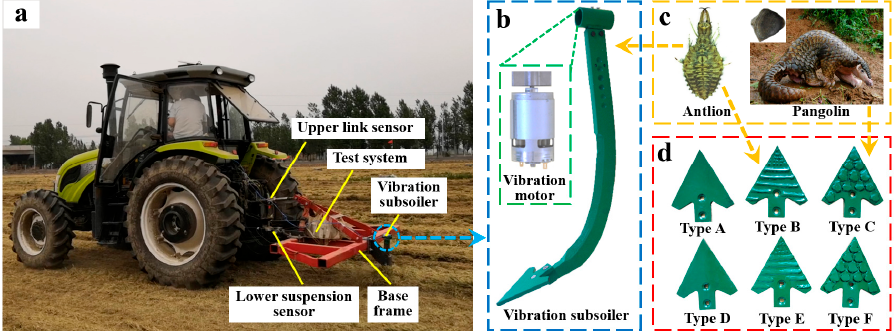
Figure 6. Design of vibrating electronic motor type subsoilers: ( a ) Traction test system; ( b ) Vibrating subsoiler; ( c ) Bionic prototypes; ( d ) Subsoiler shovel tips.